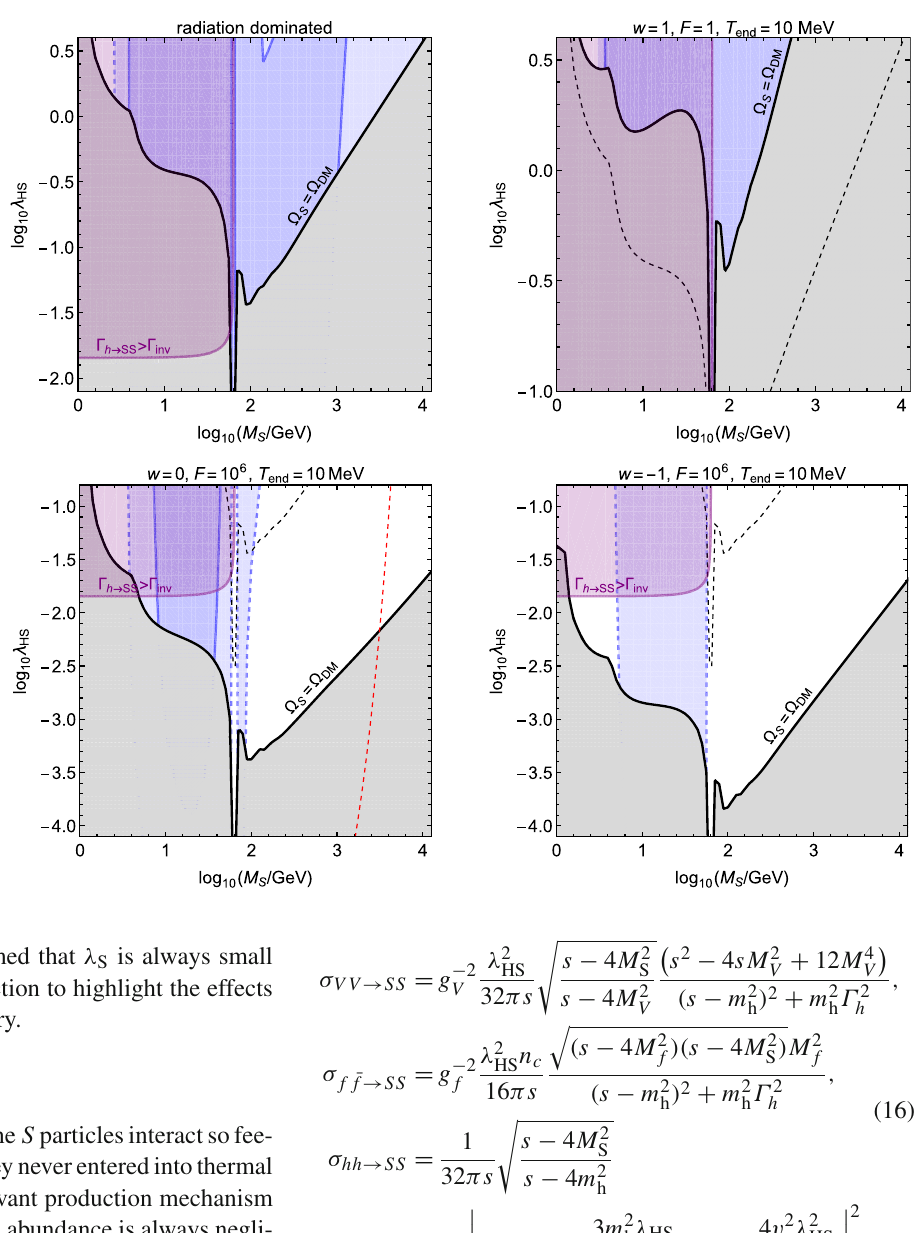
Fig. 2 In each panel, the solid black lines show the values of λ HS and M S for which the observed DM abundance for S is obtained via freeze-out. The dark blue region is excluded by direct DM searches (LUX, PandaX-II and Xenon1T), the lighter blue region shows the expected sensitivity of the DARWIN experiment, and the purple region is excluded by the LHC constraint on the Higgs boson invisible decay. The dashed black line in each panel shows the standard radiation-dominated case. Left (right) from the red dashed line in the lower left panel the DM freeze-out happens during (before) the ρ φ dominated phase. For all masses shown in the lower (upper) right panel the freeze-out happens before (during) the ρ φ